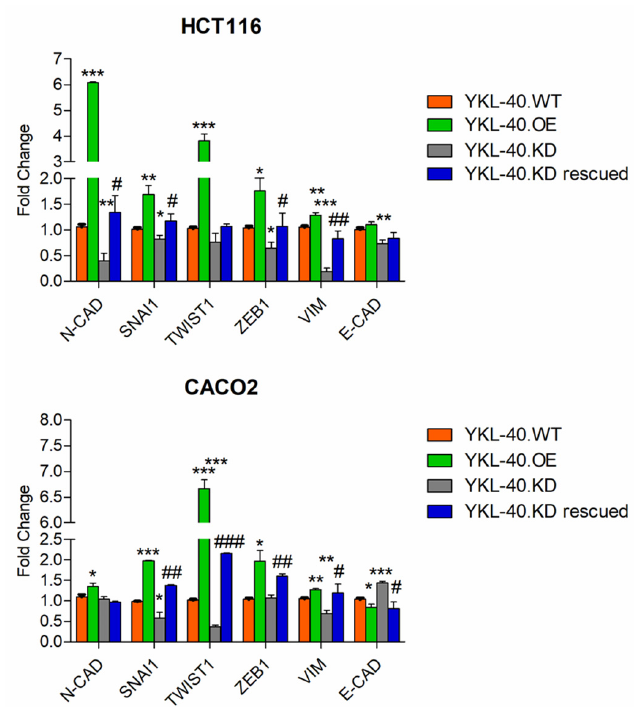
Figure 3. EMT marker expression regulation in HCT116 and Caco2 cells with modulated YKL-40 gene expression. qPCR data are shown as mean ± SD. Statistically significant differences were calculated using Student’s t test: *, normalization vs. YKL-40.WT; *, p < 0.01; **, p < 0.001; ***, p < 0.0001; #, normalization vs. YKL-40.KD; #, p < 0.01; ##, p < 0.001; ###, p < 0.0001. Data represent three independent experiments.